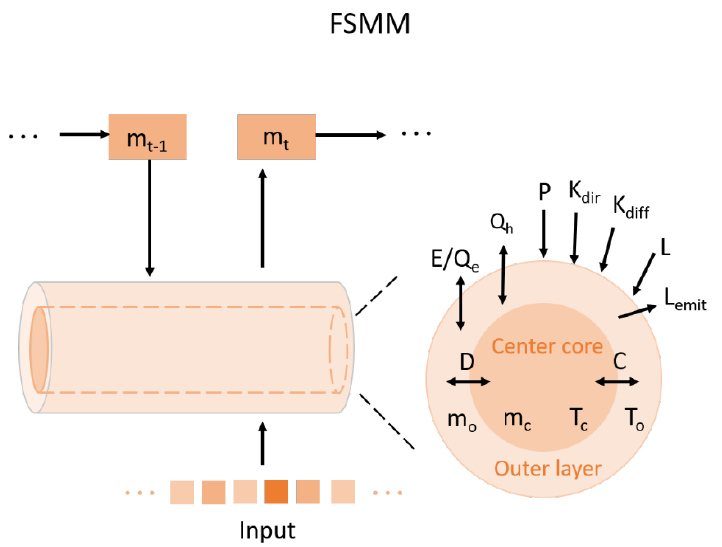
Figure 2. FSMM schematic. The m t − 1 is refer to DFMC at time t–1 while m t is the DFMC at time t. E is moisture flux between the outer layer and the atmosphere (kg/s), K is shortwave radiation (W/m 2 ), L is longwave radiation (W/m 2 ), P is precipitation (kg/s), Q is turbulent heat flux (W/m 2 ), Q h is sensible heat flux (W/m 2 ), D is diffusion into the core (kg/s) and C is conduction into the core (W).